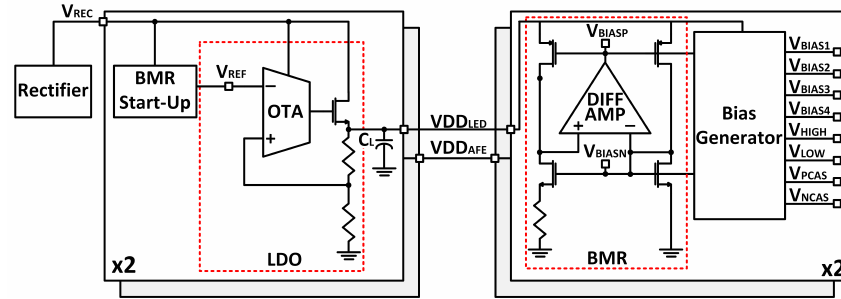
Figure 6. Transistor-level schematic of the LDO and BMR circuits.